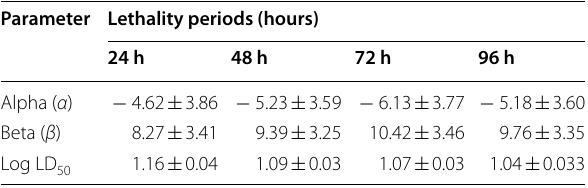
Data are represented as a mean α and β : constant values, Log LD 50 : natural logarithm of (LD 50 ) of AB 1